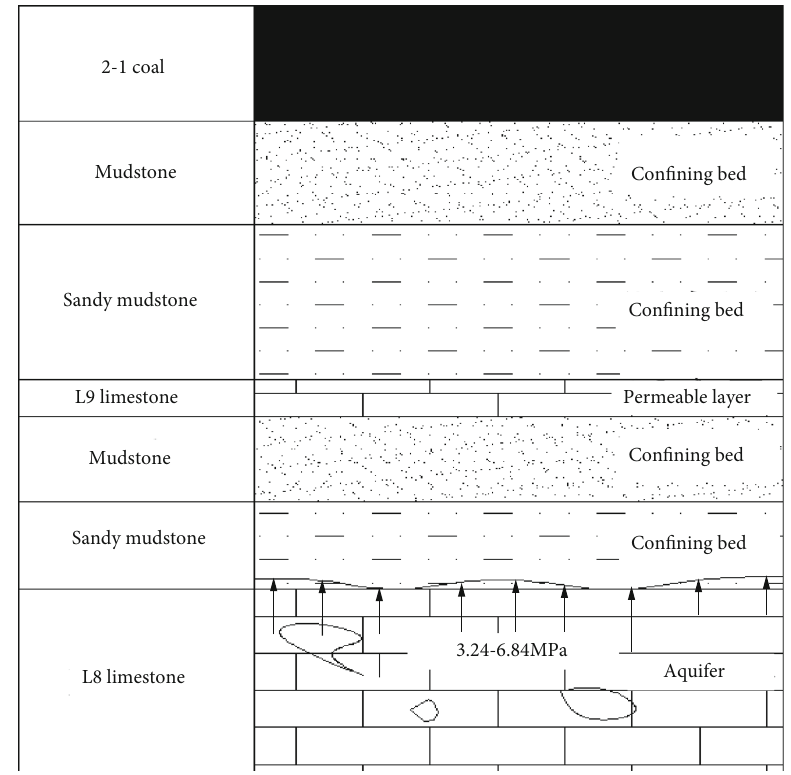
Figure 2: Schematic diagram of water barrier of fl oor rock in Zhaogu No. 2 coal mine. Table 1: Rock strength coe ffi cient of caving zone and fracture zone. Lithology R c